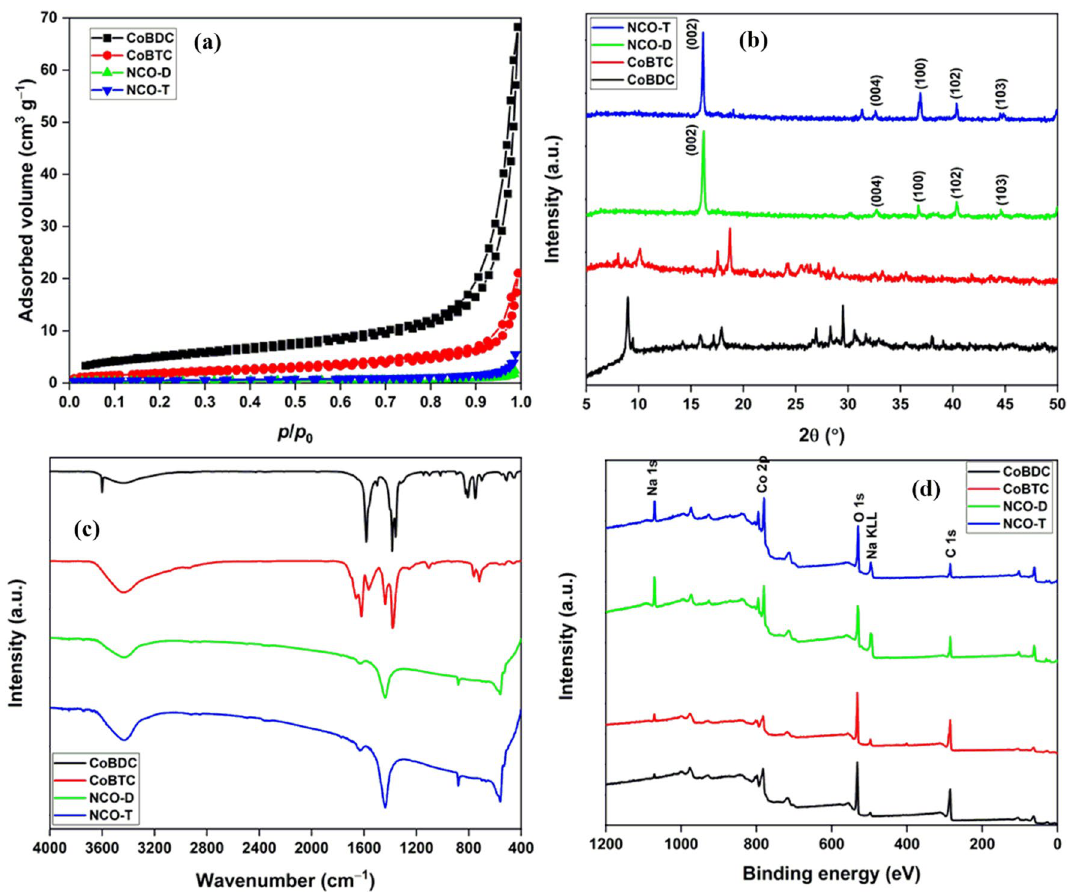
Figure 2. ( a ) N 2 adsorption–desorption isotherms ( b ) PXRD patterns; ( c ) FTIR spectra; ( d ) XPS surveys of Co-MOFs and derived